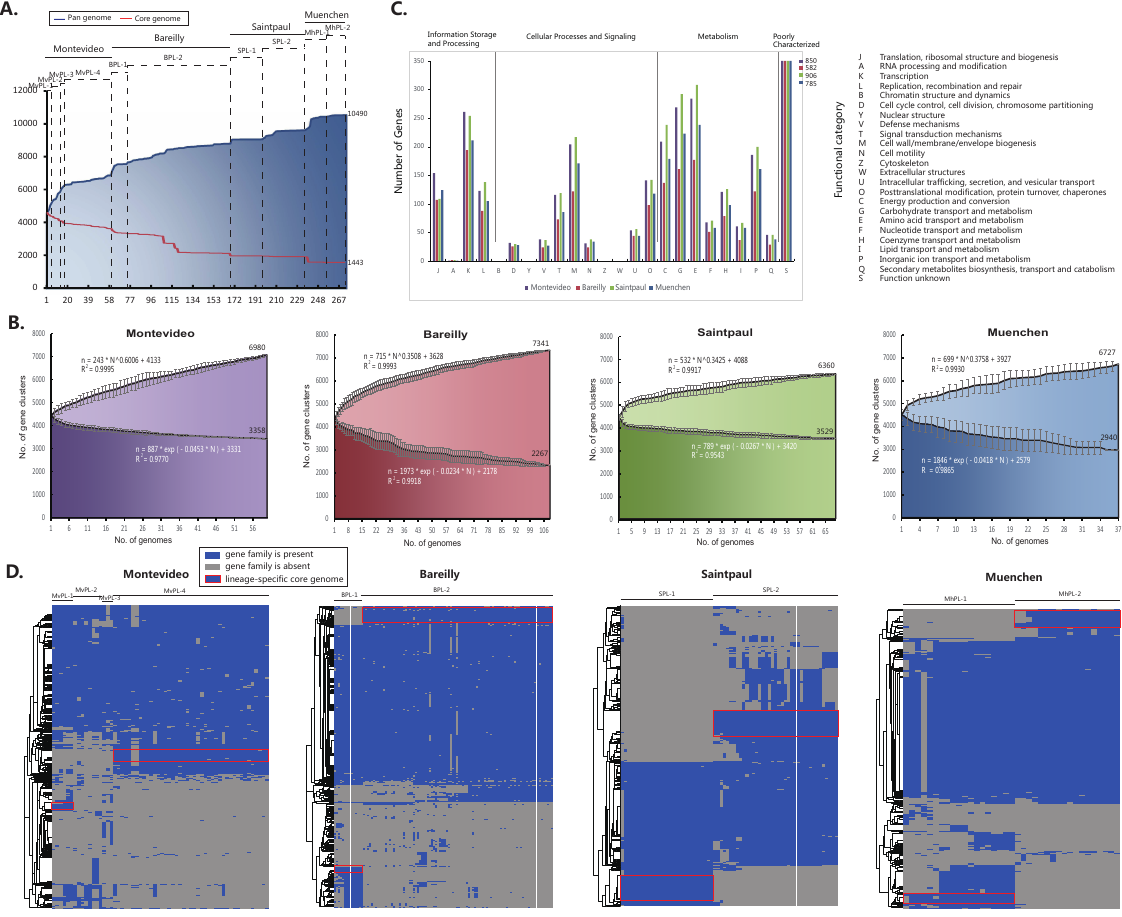
Figure 2. Core and pan genome analysis. ( A ) Core and pan genome curves for strains in lineages of Montevideo, Bareilly, Saintpaul, and Muenchen. ( B ) Increase and decrease in gene families in the pan genome and core genome. Black spots are the averages of each value. Error bars indicate standard deviation in the number of core and pan gene clusters among di ff erent strains. The deduced mathematical functions of core and pan genome curves are also reported. ( C ) Distribution of clusters of orthologous group (COG) catalogues of core gene families. ( D ) Cluster map of the accessory genome. The gene families that are unique to a lineage and conserved across most strains in that lineage are framed in